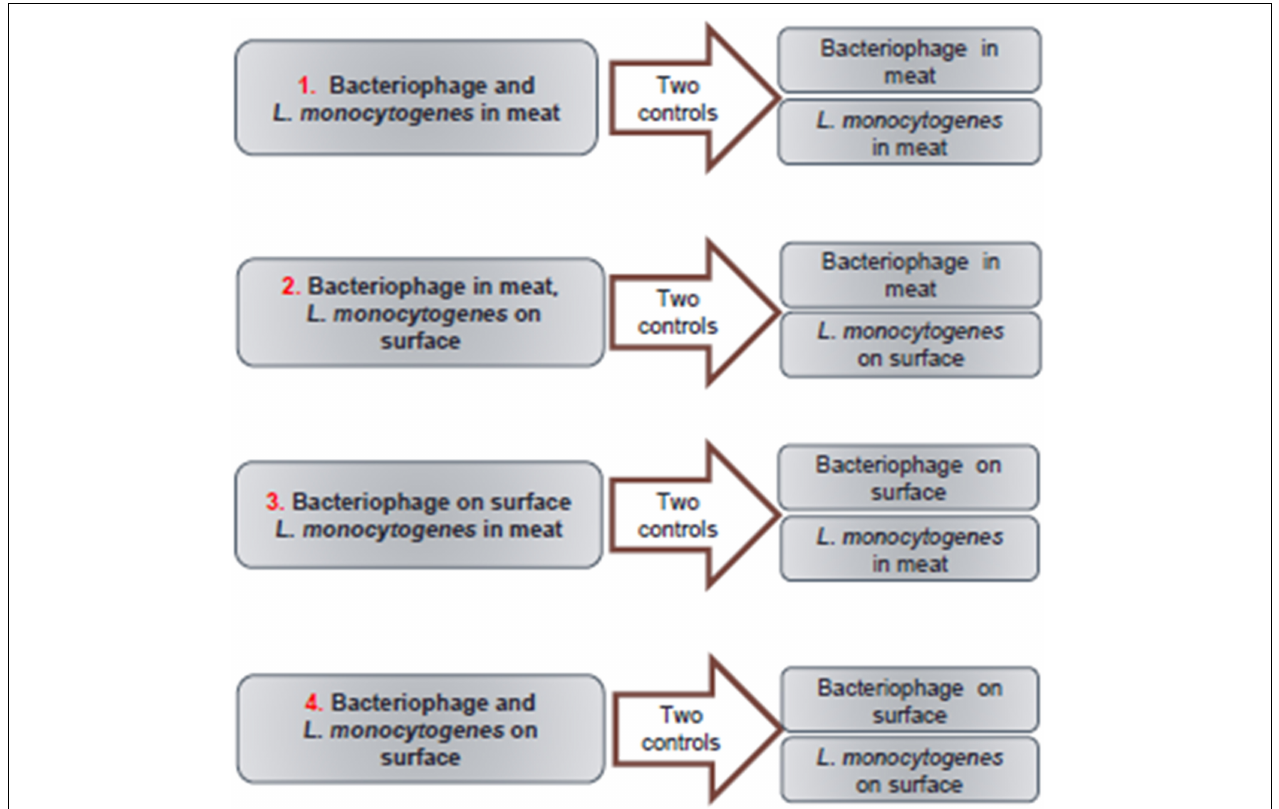
FIGURE 1 | Flow chart showing experimental design, treatments, and appropriate controls for each treatment.